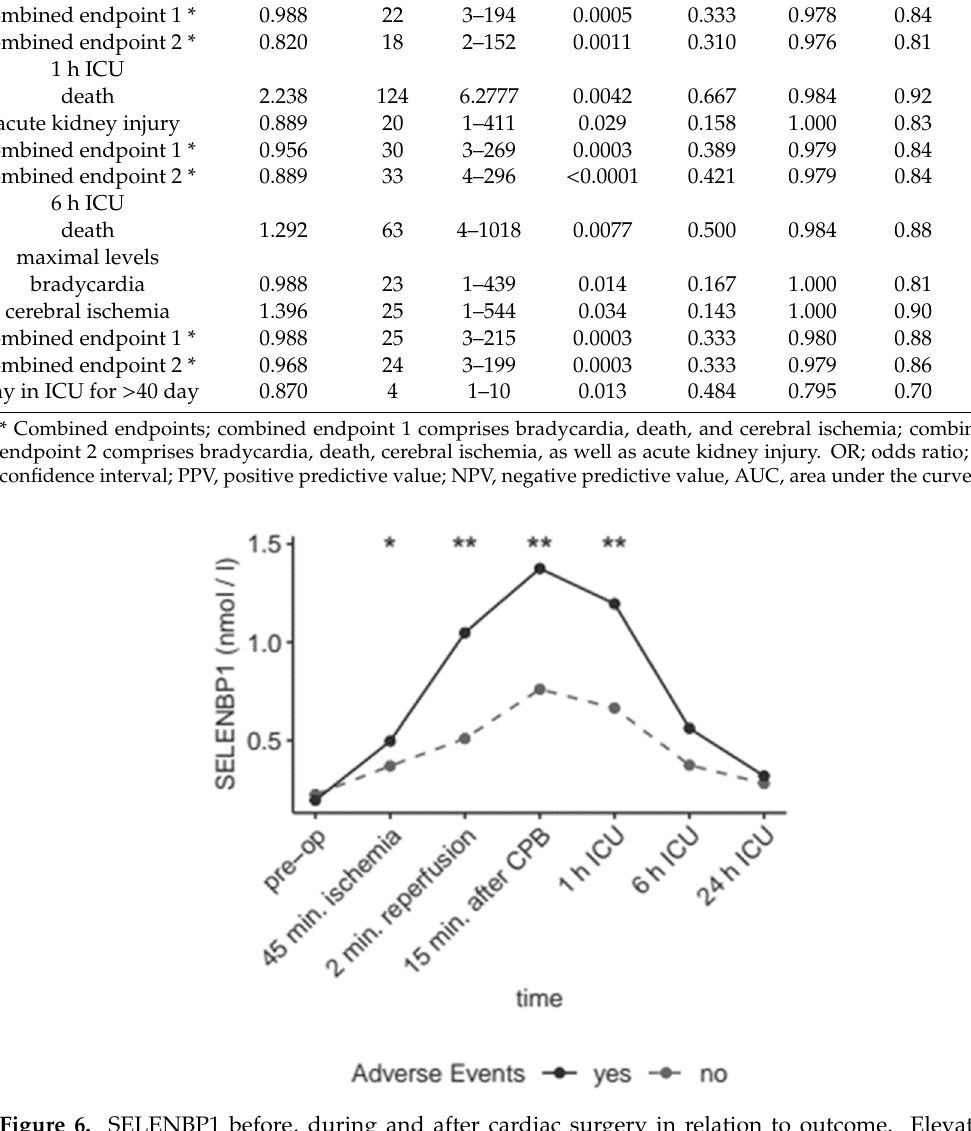
Table 2. Association of elevated serum SELENBP1 concentrations with adverse outcomes.